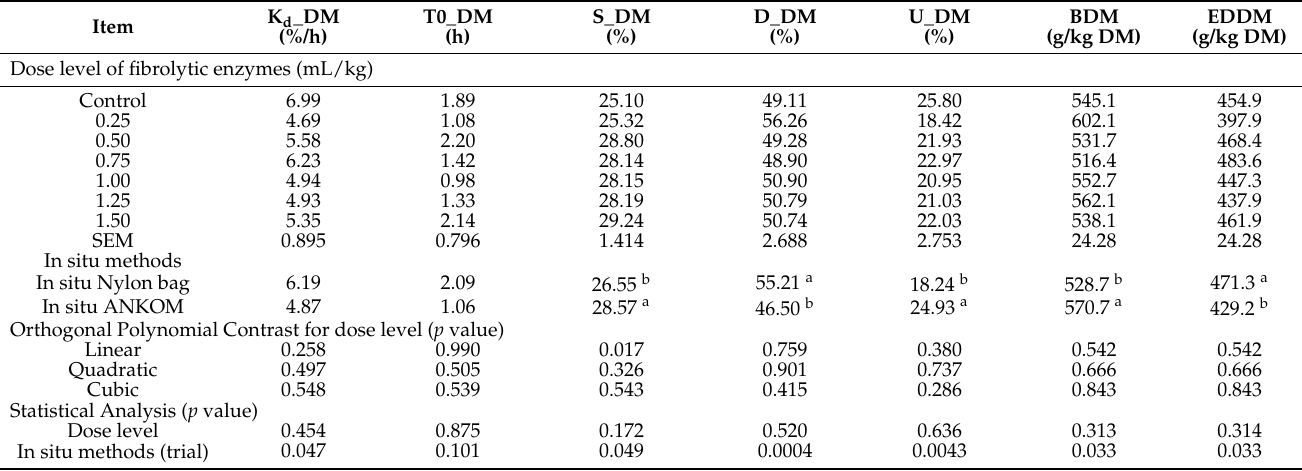
Table 5. Effect of dose level of fibrolytic enzymes 1 derived from Trichoderma reesei on in situ rumen DM degradation kinetics of whole plant faba bean silage using both in situ nylon bag and in situ ANKOM methods.